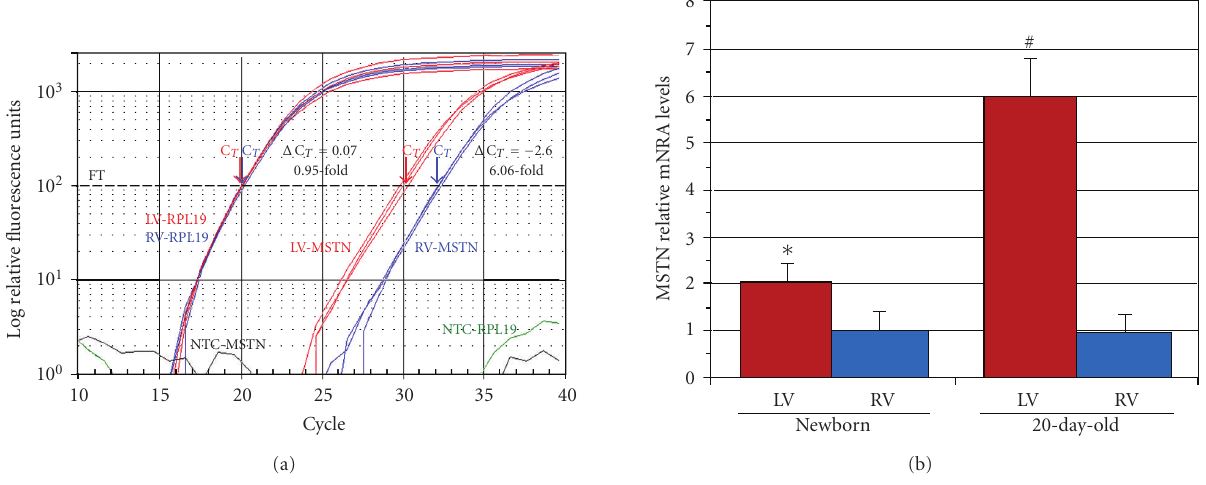
Figure 4: Estimation of myostatin (MSTN) mRNA levels in the LV and RV of newborn and 20-day-old piglets. (a) Representative qPCR amplification plot of MSTN mRNA levels in the LV (red) and RV (blue) of three 20-day-old piglet hearts. Internal RPL19 reference levels in the LV (red) and RV (blue) are shown. Arrows: threshold cycle (C T ). FT: fluorescent threshold. Δ C T : di ff erences in threshold cycles for target and reference. NTC: nontemplate controls. B: MSTN mRNA levels in the LV versus RV ventricle of newborn and 20-day-old piglets. ∗ P < . 05, newborn piglets ( n = 3). # P < . 05, 20-day-old piglets ( n =